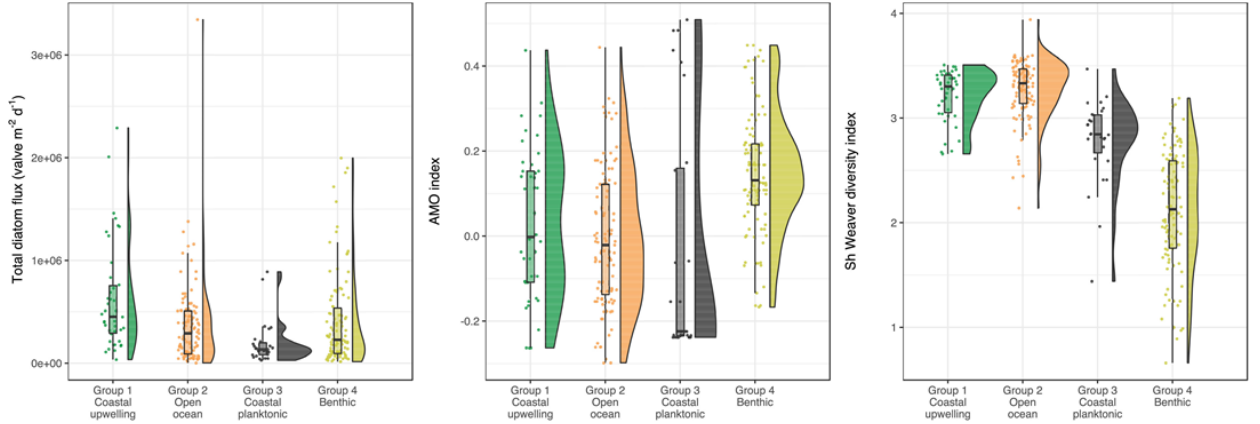
Figure 4. Comparison of clusters extracted from multivariate analysis according to total diatom flux, AMO, and Shannon diversity measured.